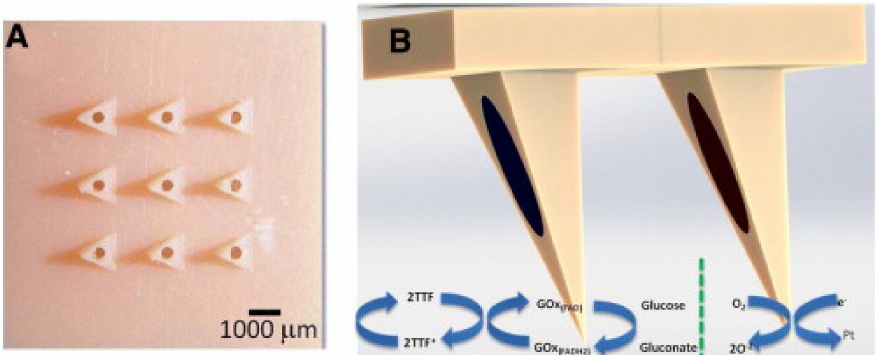
Figure 6. ( A ) Optical micrograph of the MN array. ( B ) Hollow MNs packed with carbon paste. Bioanode (left) was covered with a CNT/TTF/GOx-BSA/glutaraldehyde/Nafion ® layer. Cathode (right) was prepared by electrodepositing a Pt–Rh alloy on bundles of carbon fibres, followed by Nafion ® dip coating. A schematic representation of reactions happening at each electrode is also shown. Reproduced with permission from Reference